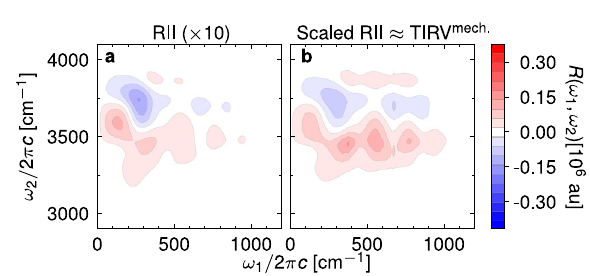
Fig. 3 | Analysis of the mechanical anharmonic coupling. a RII spectrum with μ ind =0 simulated using classical MD at 300K (multiplied by 10 so that the spectral features can be seen on the same scale as in panel b ). b The same spectrum mul-